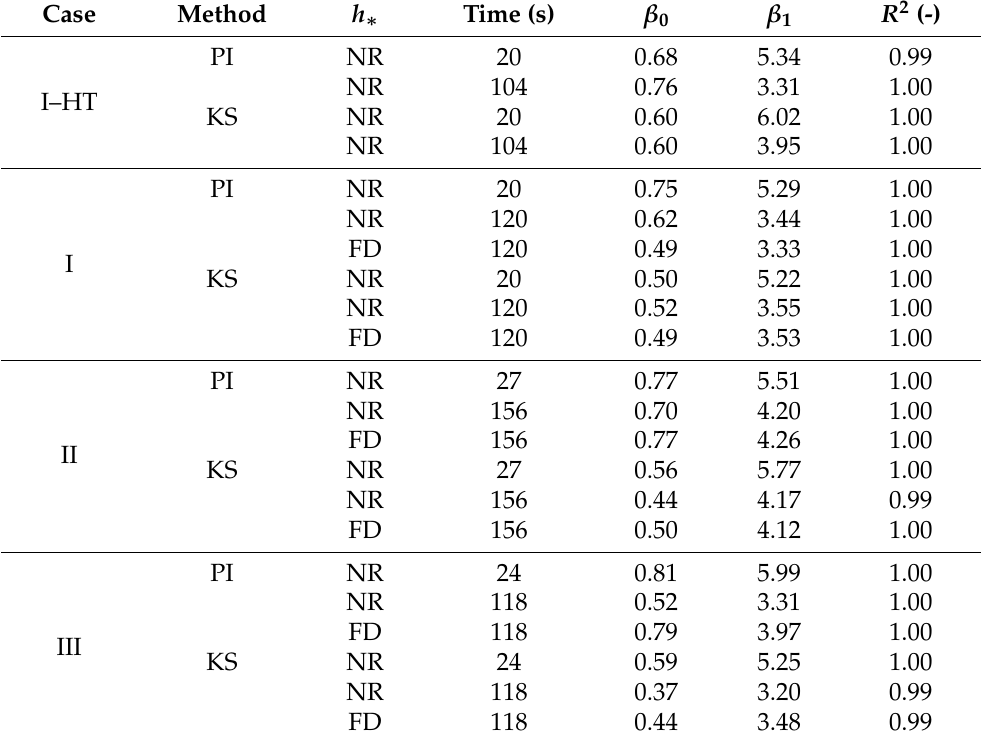
Table 2. Convergence study results. PI refers to estimator (24) and KS to (6). The case column refers to the cases in Table 1. Column h ∗ displays the method to evaluate the Laplacian in the bandwidth of kernel K 1 in Equations (37) and (38): NR refers to normal reference rule (13) and FD to finite differences. The time column gives the simulated time at which the MISE is calculated. Columns β 0 and β 1 display the estimated coefficients from Equation (41). Column R 2 displays the R -squared value of the fits.